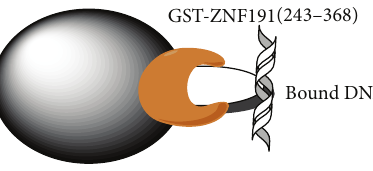
Figure 2: Schematic representation of DNA selecting of GST- ZNF191(243-368). Glutathione sepharose 4B is bound by the GST of fusion protein. Meanwhile, the zinc finger protein binds its